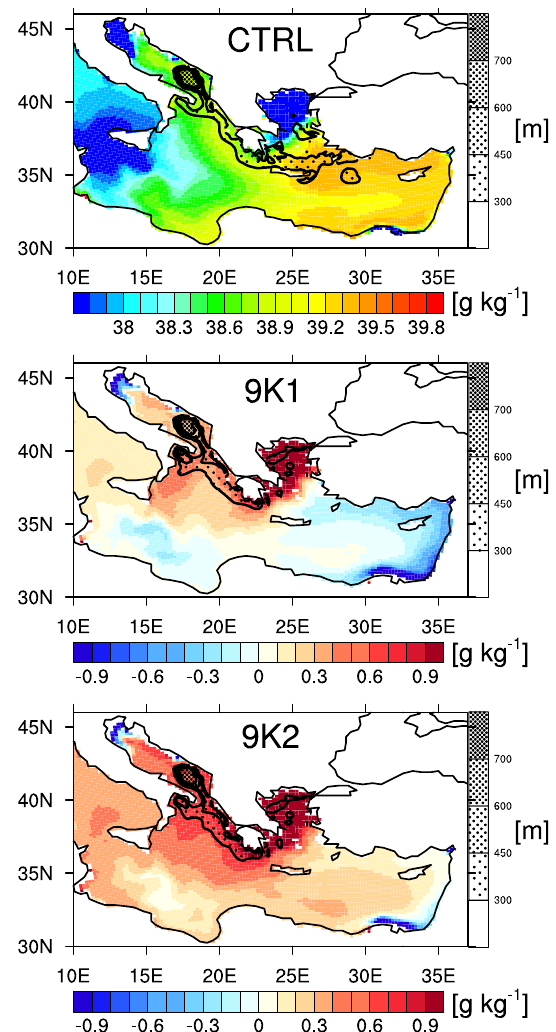
Fig. 9. Annual mean SSS (CTRL, top) and SSS anomalies vs. CTRL (9K1, middle; 9K2, bottom) at 6m depth (colours). March mixed layer depth is overlaid as fill